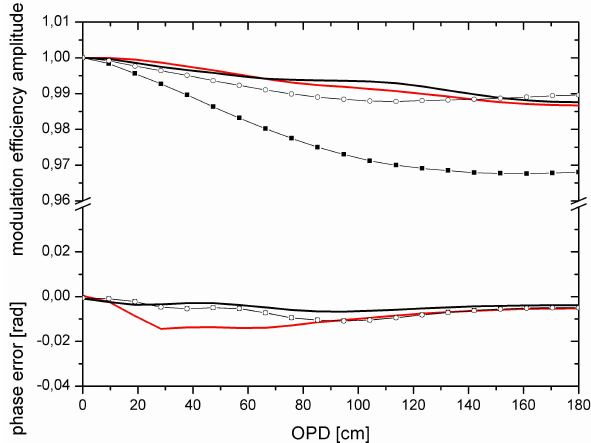
Fig. 6. The normalized retrieved modulation efficiency and phase error for July (black) and October (red) as derived from the cell C1; only a moderate change of the ILS is indicated over the three-month period. Curves with symbols: modulation efficiency derived from the HBr cell in early November (black squares: assuming nominal pressure of 240Pa, open circles: assuming 280Pa total pressure).